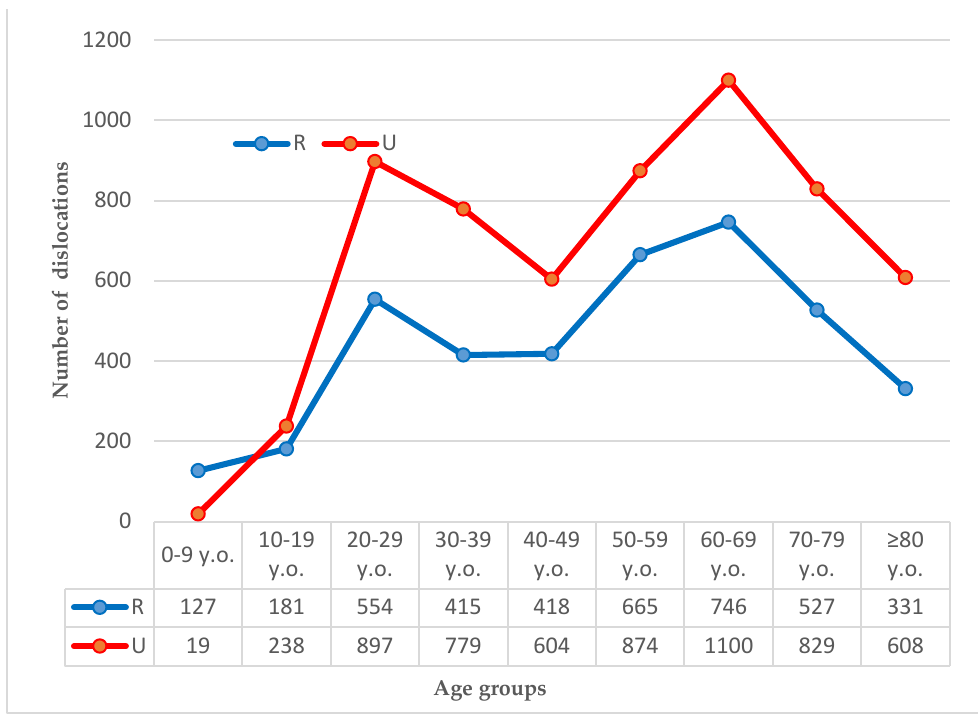
Figure 1. Number of dislocations per age group . Legend: R, rural population; U, urban popula- tion.